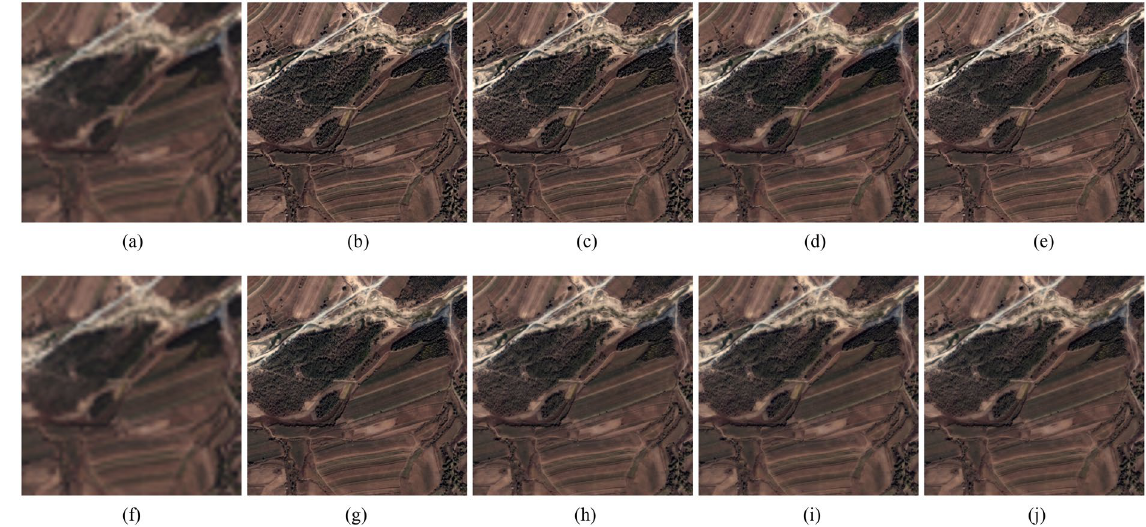
Figure 5. IKONOS images fusion results. ( a ) the LRMS image. ( b ) GSA method. ( c ) CBD method. ( d ) BDSD method. ( e ) BF method. ( f ) MMMT method. ( g ) RBDSD method. ( h ) ASIM method. ( i ) DIM method. ( j ) Proposed method.